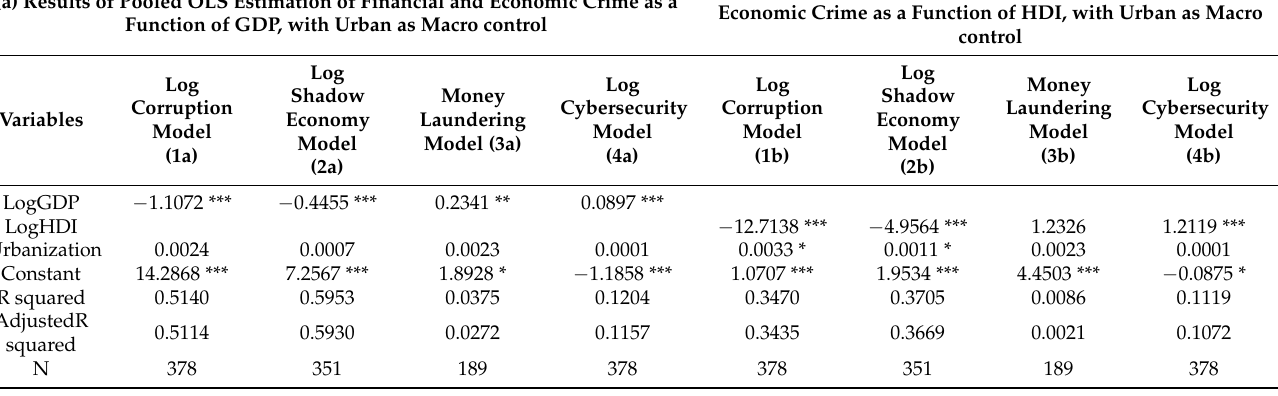
Table 4. Simple regression modeling—Robustness checks (2) with Urbanization rate. (b) Results of Pooled OLS Estimation of Financial and Economic Crime as a Function of HDI, with Urban as Macro